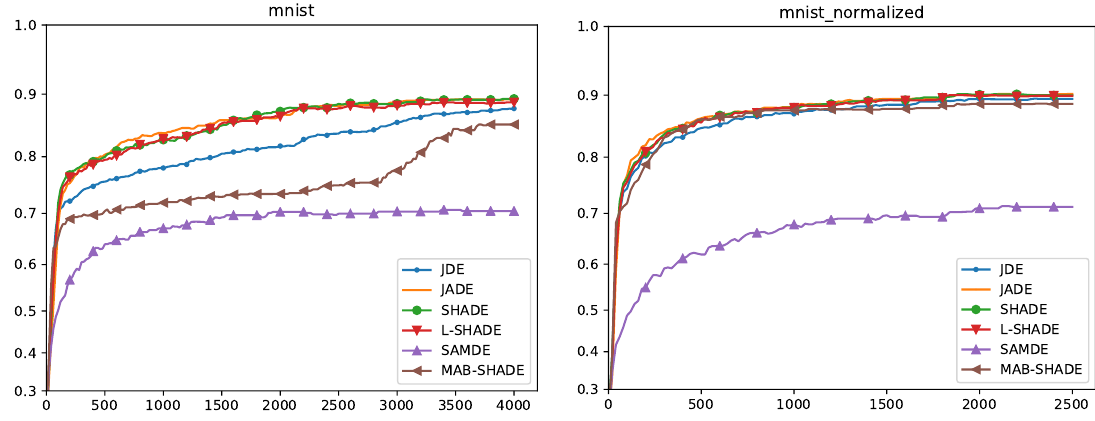
Figure 4. Plots of convergences on MNIST and MNIST normalized